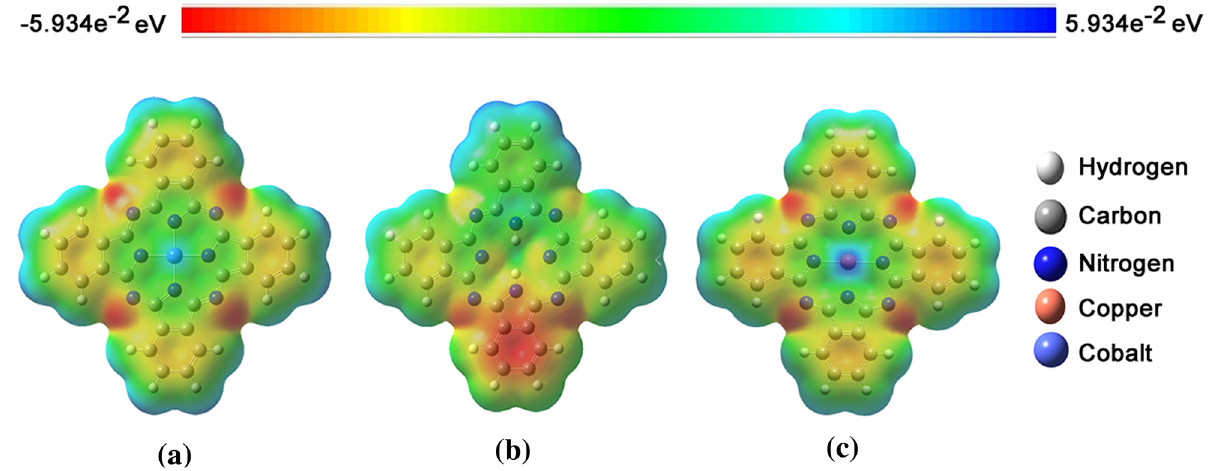
Figure 6. The MESP for: ( a ) CoPc, ( b ) NoPc, e ( c ) CuPc, B3LYP / LANL2DZ level of